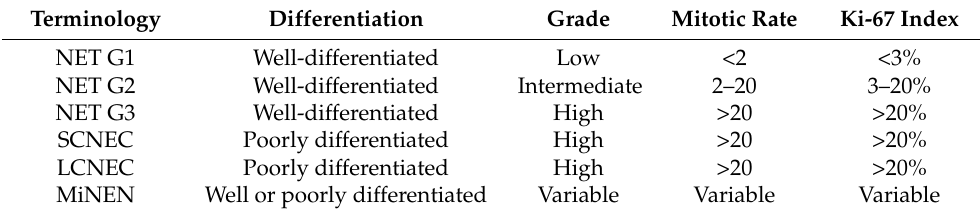
Table 2. In general, Grading criteria for neuroendocrine